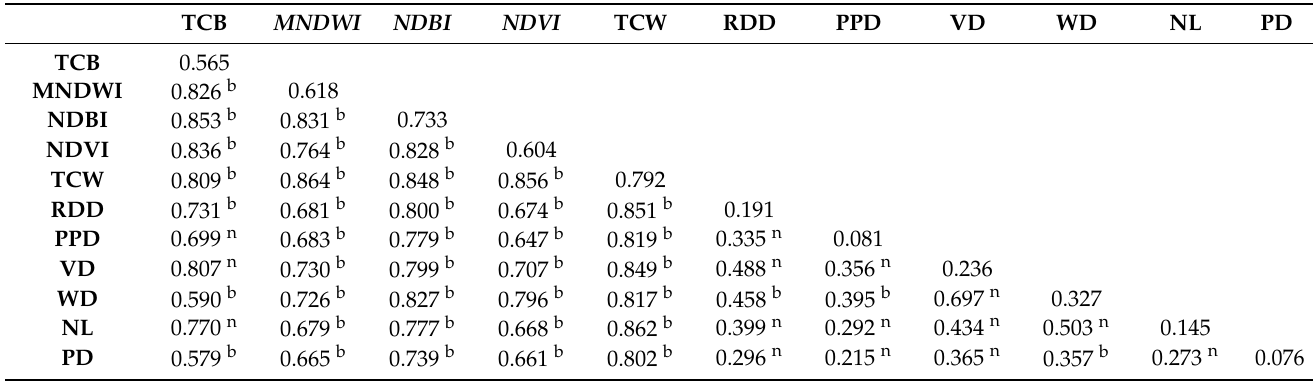
Table 3. The interaction of multiple